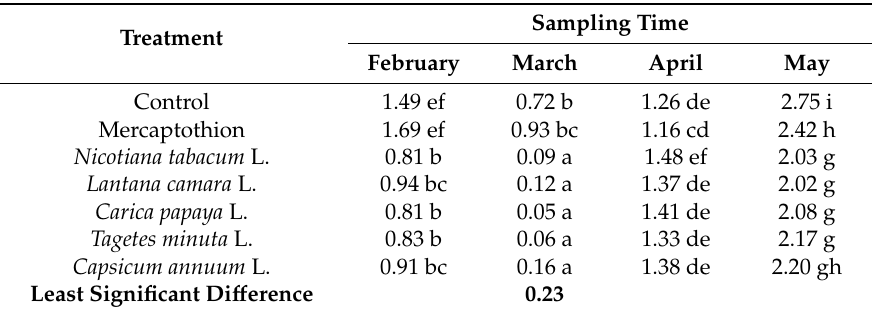
Table 4. Aphid abundance across sampling time.